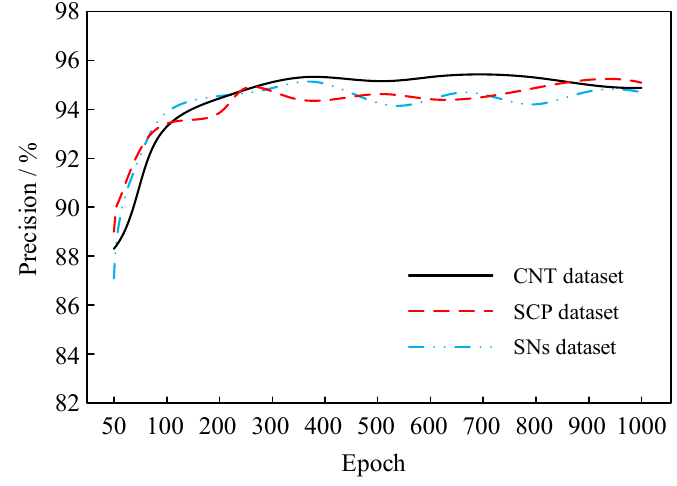
Figure 5. Influence of iteration epoch on precision.